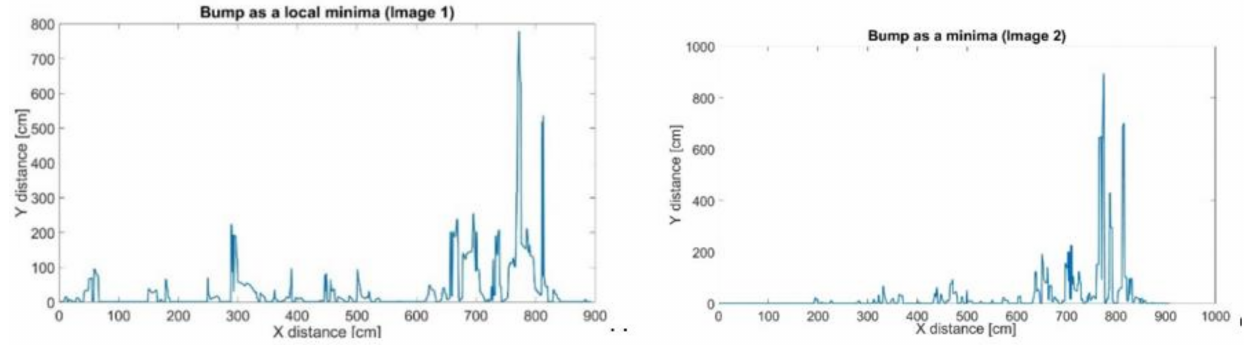
Figure 13. Computation of local minima for image 1 ( left ) and image 2 ( right ).